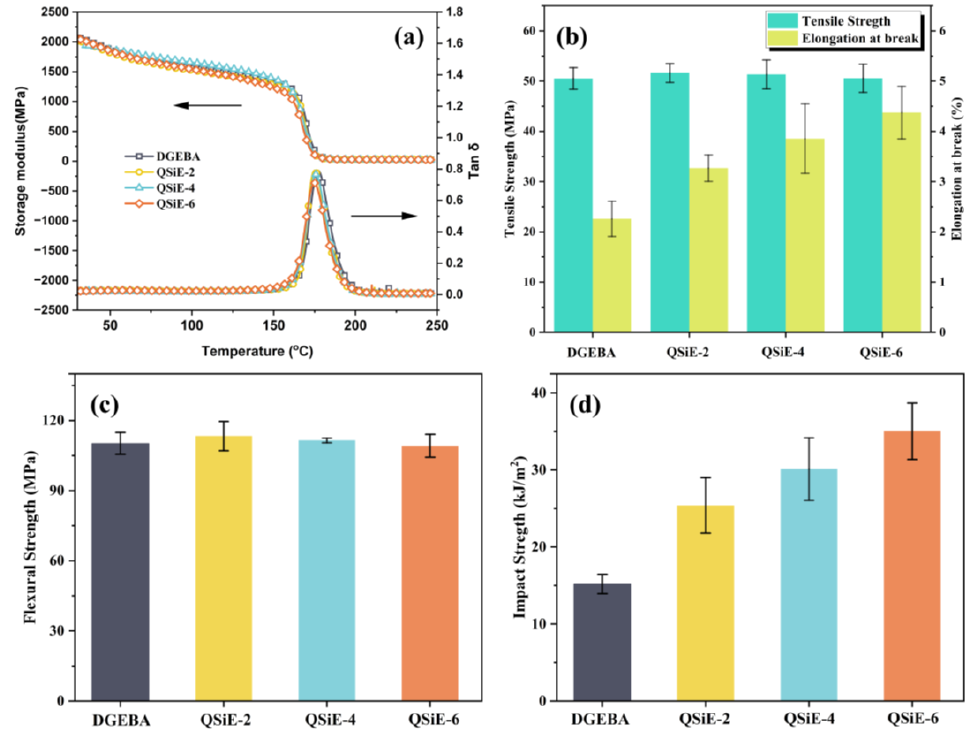
Table 2. Thermal-mechanical properties of cured thermosets.